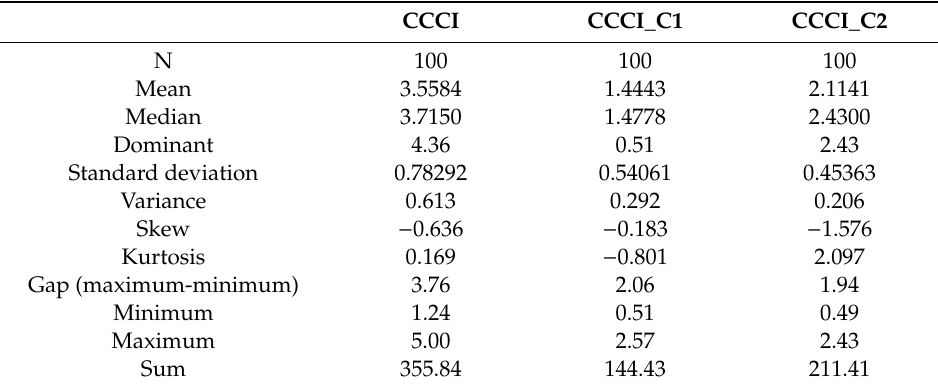
Table 21. Descriptive statistics for CCCI two components of CCCI.